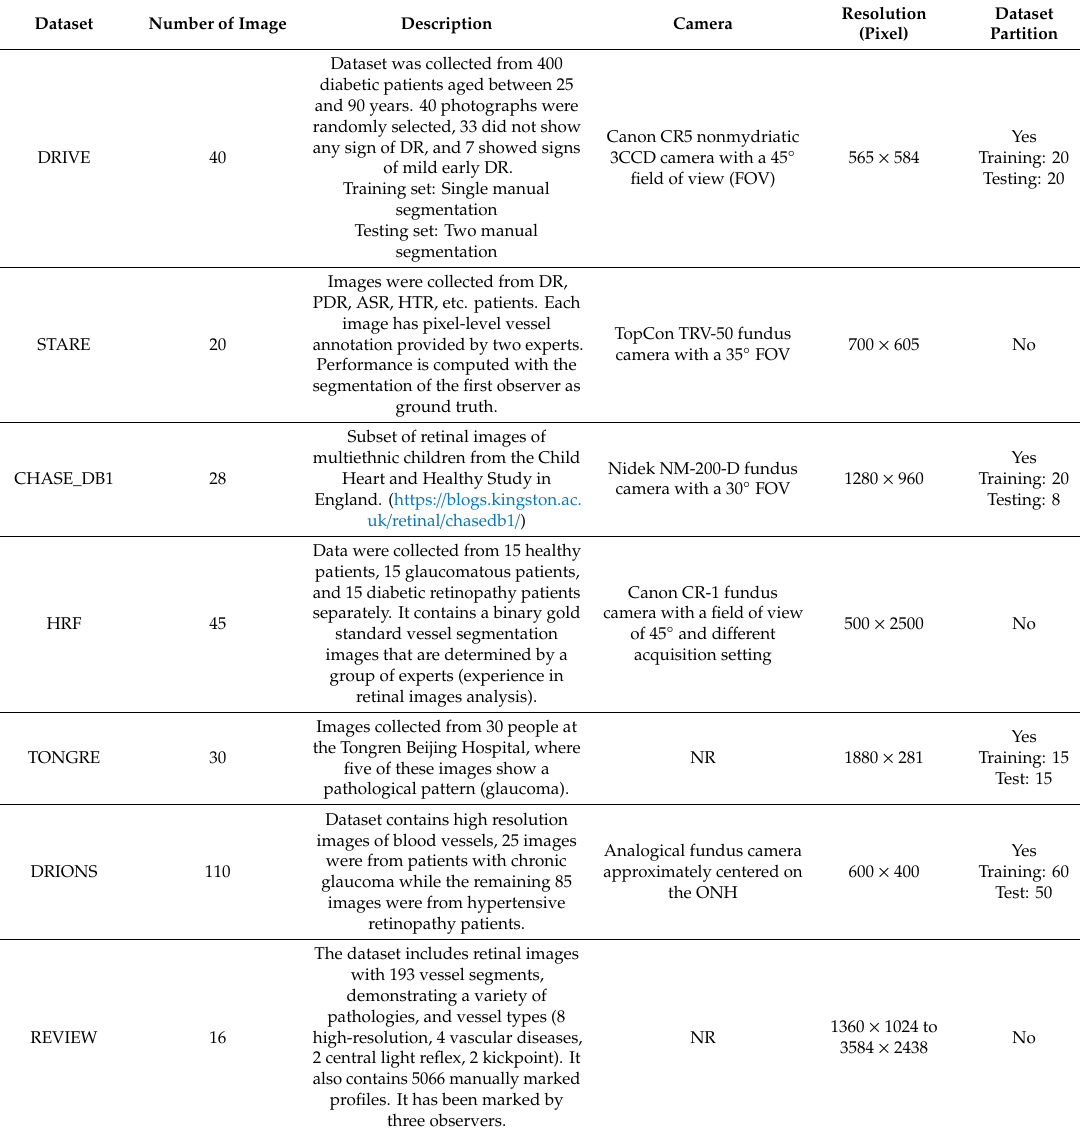
Table 2. Description of